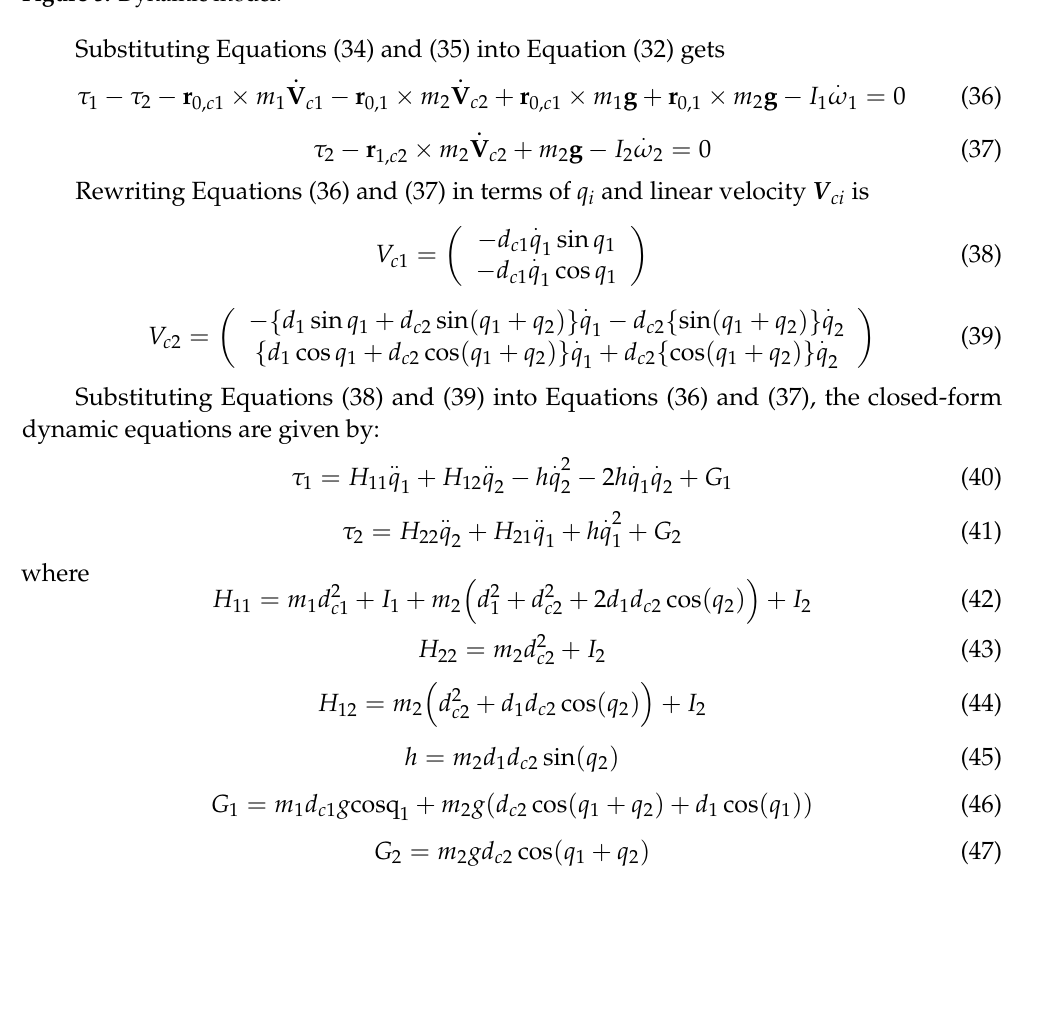
Figure 5. Dynamic